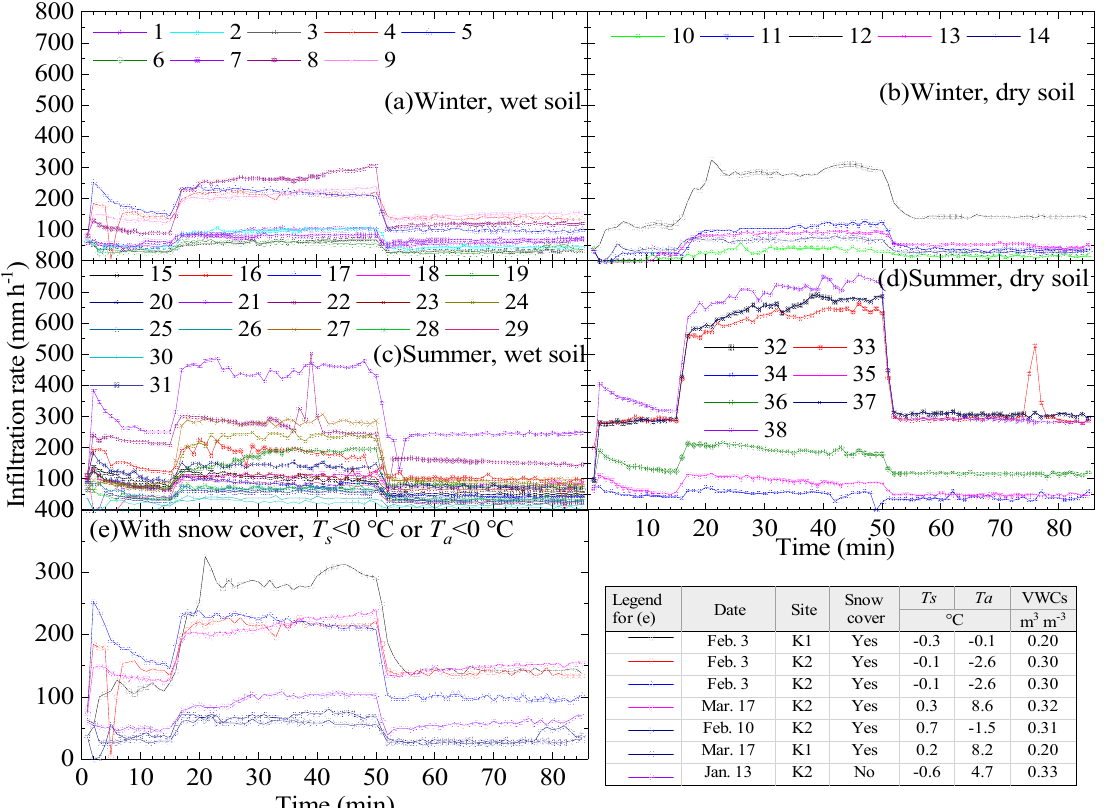
Figure 5. Infiltration rates under ( a ) wet and ( b ) dry soil moisture conditions and in winter (November to March), and under ( c ) wet and ( d ) dry soil moisture conditions in summer (June and July), and under ( e ) special conditions in winter (with snow cover, T s < 0 ◦ C, or T a < 0 ◦ C). Wet soil refers to an antecedent soil volumetric water content (VWC) higher than 0.25 m 3 · m − 3 , while dry soil had a VWC below this value. T a is air temperature, and T s is soil temperature. Each line represents a single infiltration run, with the legend numbered values corresponding to the “Number” column in Table 3.